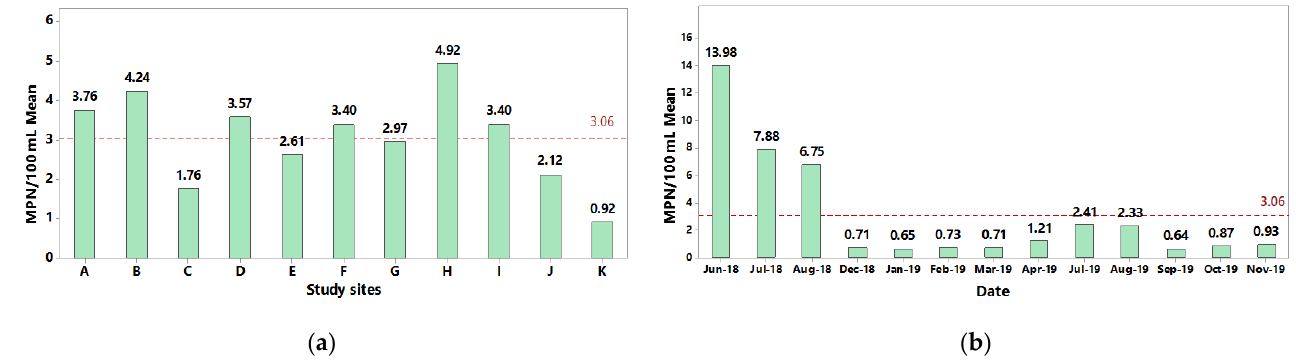
Figure 2. Estimation of Salmonella levels recovered from river water samples. A standardized analytical protocol employing culturing, biochemical, and molecular confirmation [28] was used to determine the Salmonella levels based on the most probable number (MPN) technique per 100 mL of sample for the various sites ( a ) and dates ( b ). The red dashed line represents the overall mean of Salmonella levels for all sampling sites and dates.